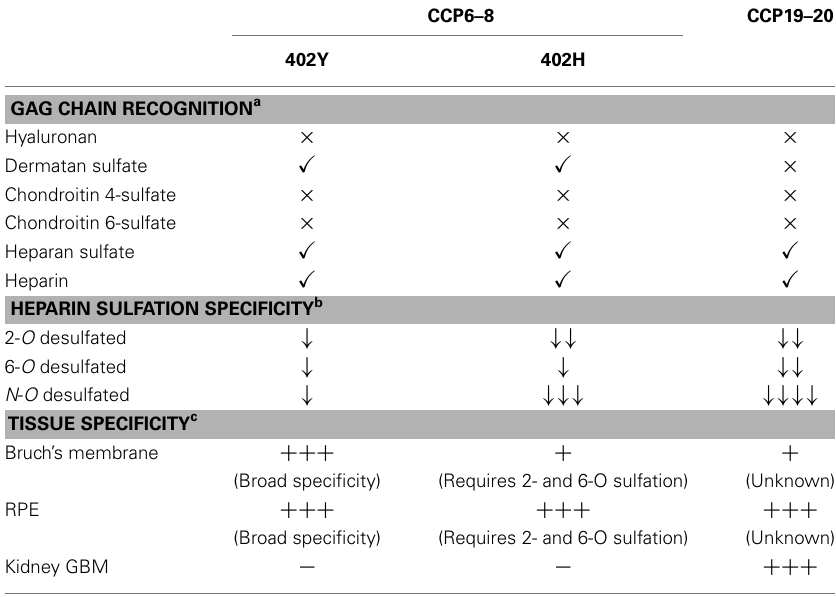
Table 1 | Comparison of the binding properties of the two GAG-binding regions of CFH